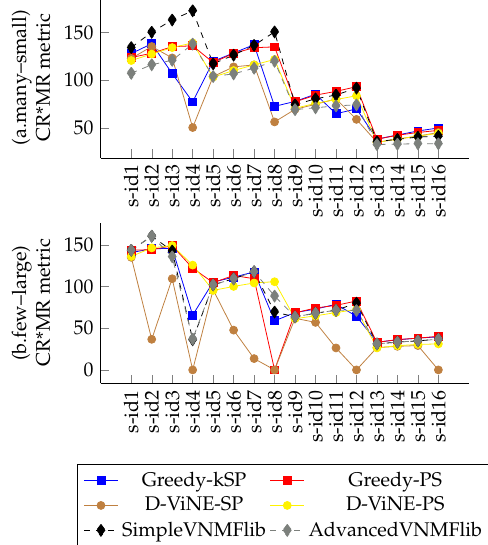
Figure 5. Provisioning costs of the examined